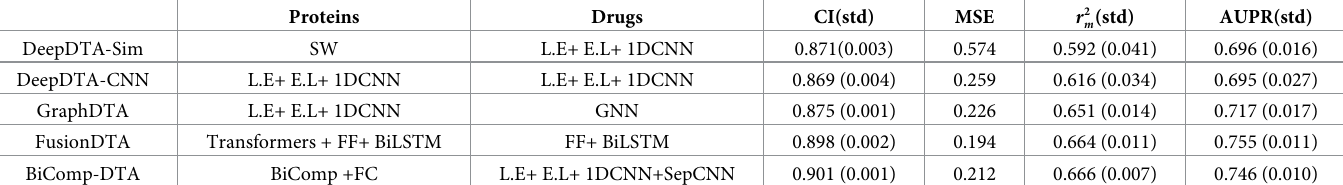
Table 5. The CI, MSE, r 2 and AUPR values for the BiComp-DTA compared to the alternative methods—refined Davis m